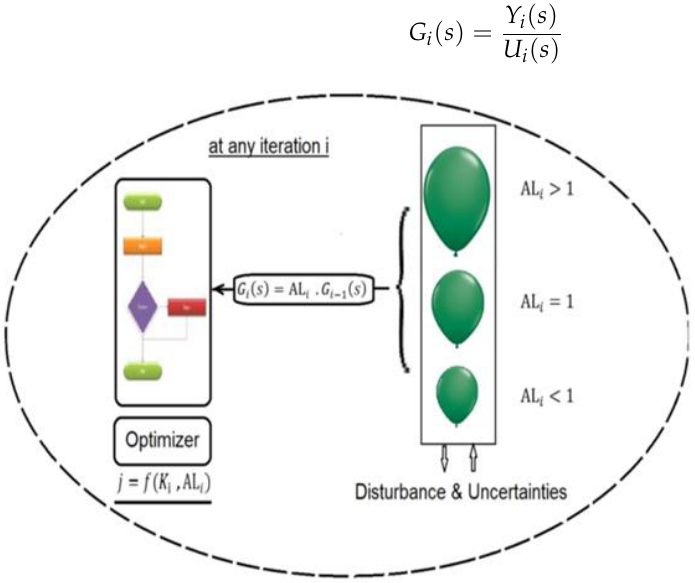
Figure 3. Balloon effect concept for any optimizers at iteration (i).